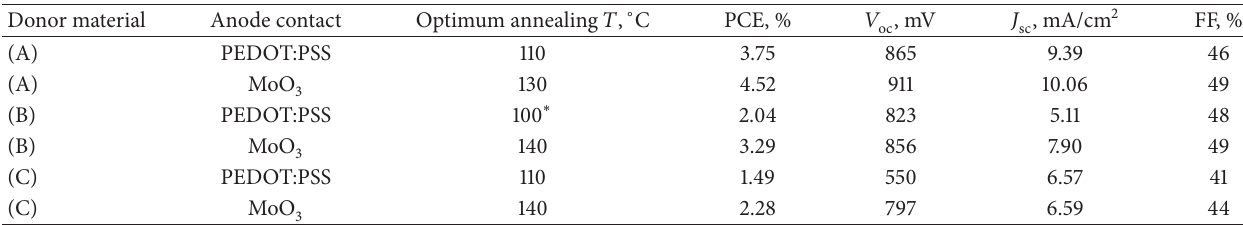
Table 2: Main parameters of the fabricated solar